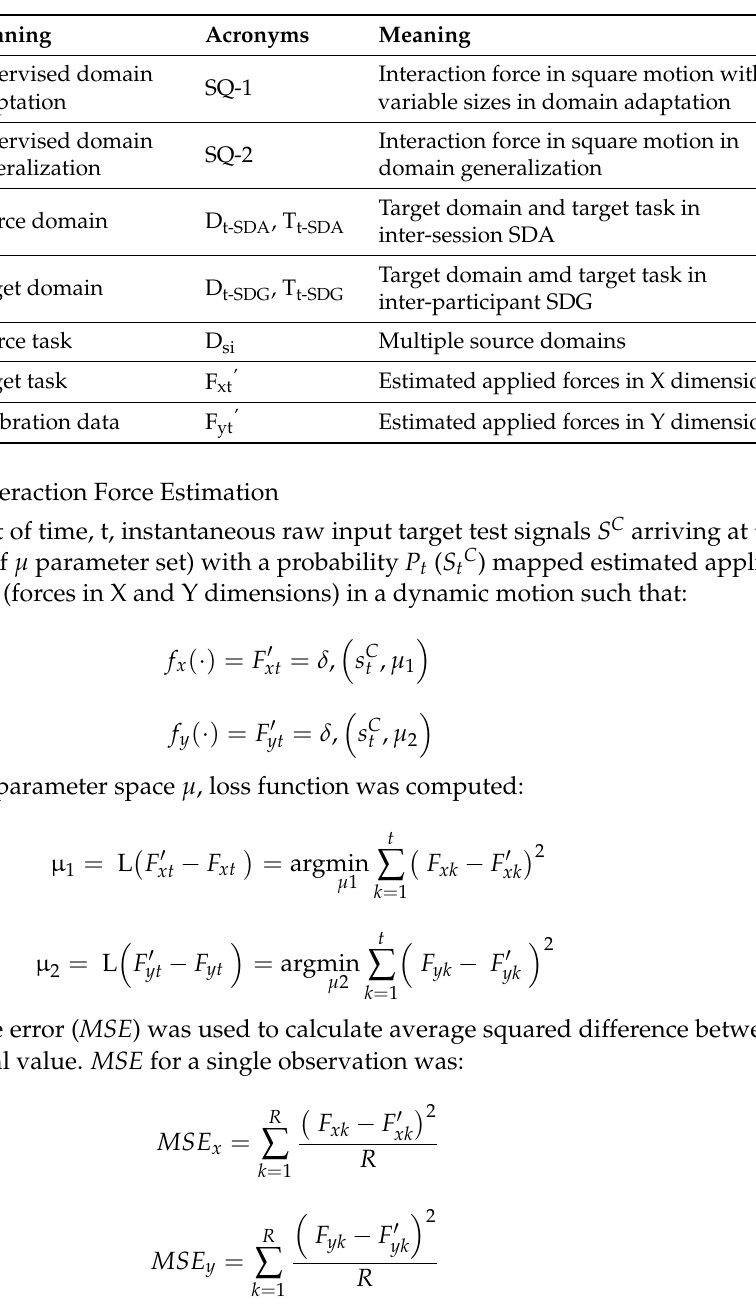
Table 1. Acronyms